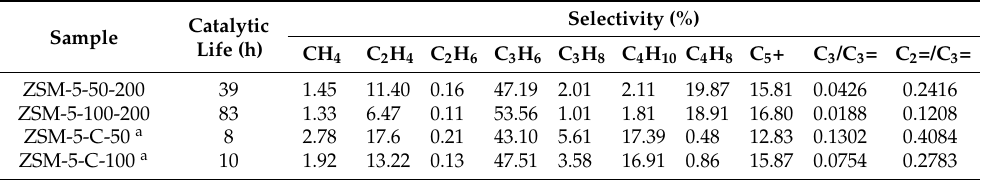
Figure 16. DME conversion ( a ) and overall product selectivity ( b ); selectivity for various products with TOS for ZSM-5-50-200 ( c ) and ZSM-5-100-200 ( d ). Table 3. DTO catalytic result of ZSM ‐ 5 ‐ 50 ‐ 200 and ZSM ‐ 100 ‐ 200 compared with ordinary ZSM ‐ 5 samples.